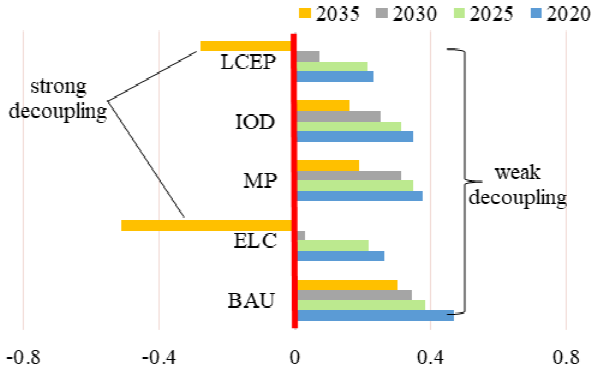
Figure 8. Degrees of decoupling of CO 2 emissions growth ( ∆ CO 2 ) from economic growth ( ∆ GDP) for Changxing County in five scenarios.